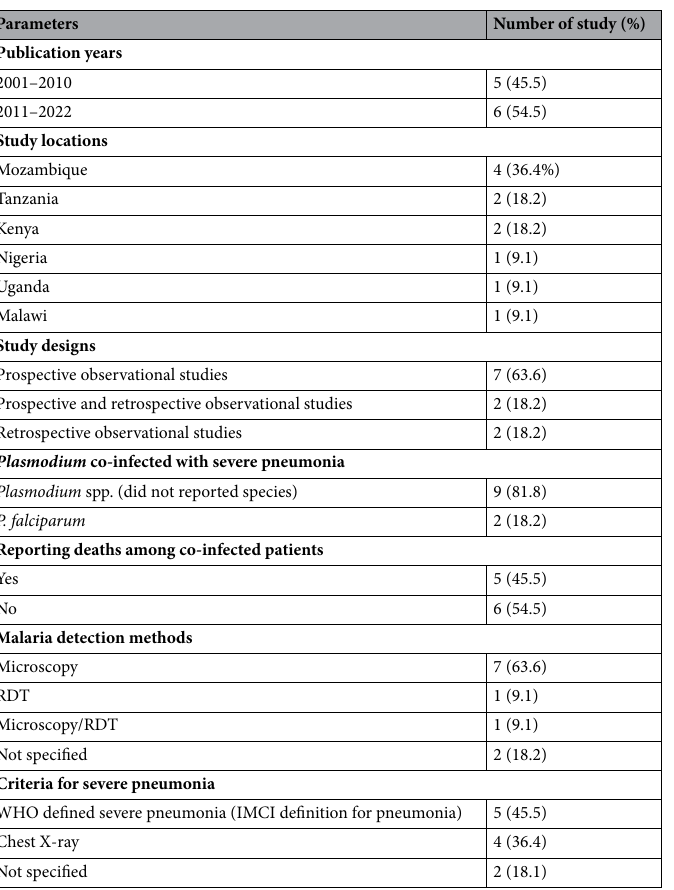
Table 1. Summary statistics of 11 included studies. IFA, immunofluorescence antibody; MAT, microscopic agglutination tests; RDT, rapid diagnostic test; PCR, polymerase chain